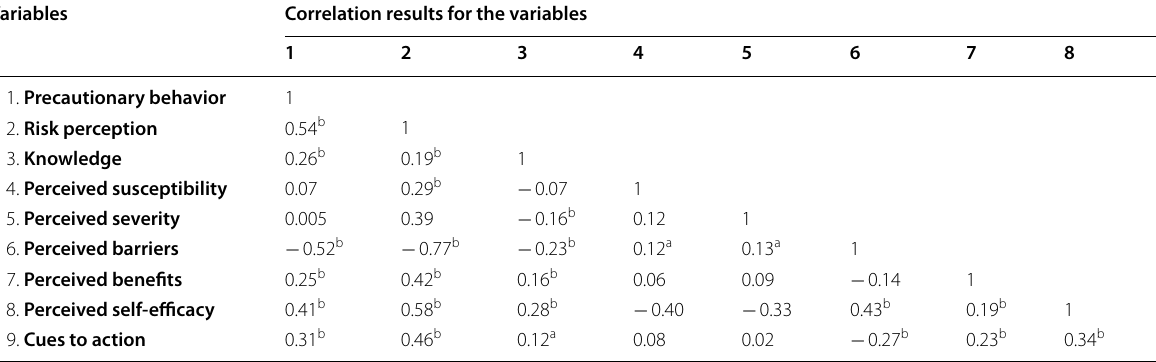
Table 4 Correlation between COVID-19 precautionary preventive behavior, related knowledge, and constructs of the health belief model among health sciences